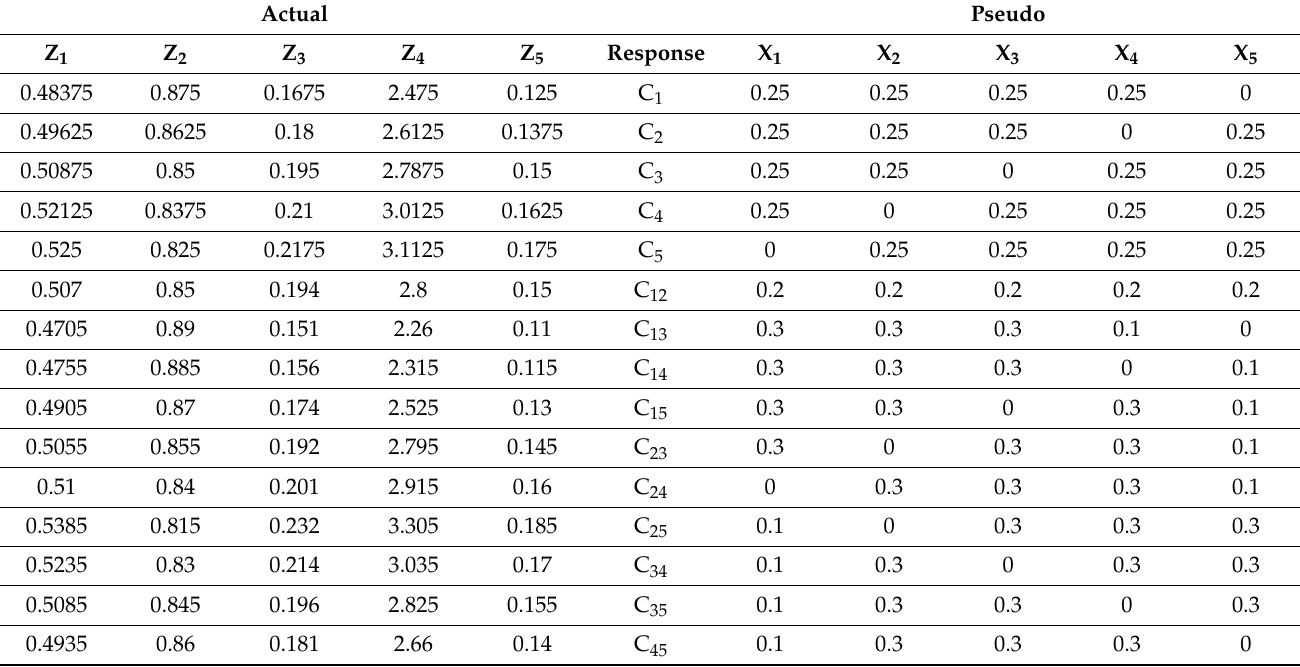
Table 2. Mixture Proportion Formulation for Control